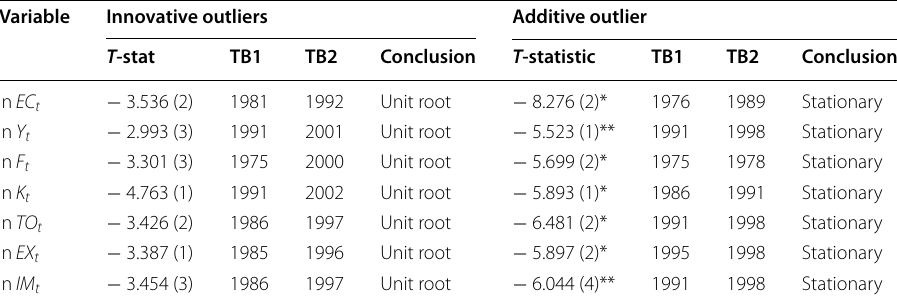
* and ** indicate p‑values at 1% and 5% levels. Lag length of variables is shown in small parentheses